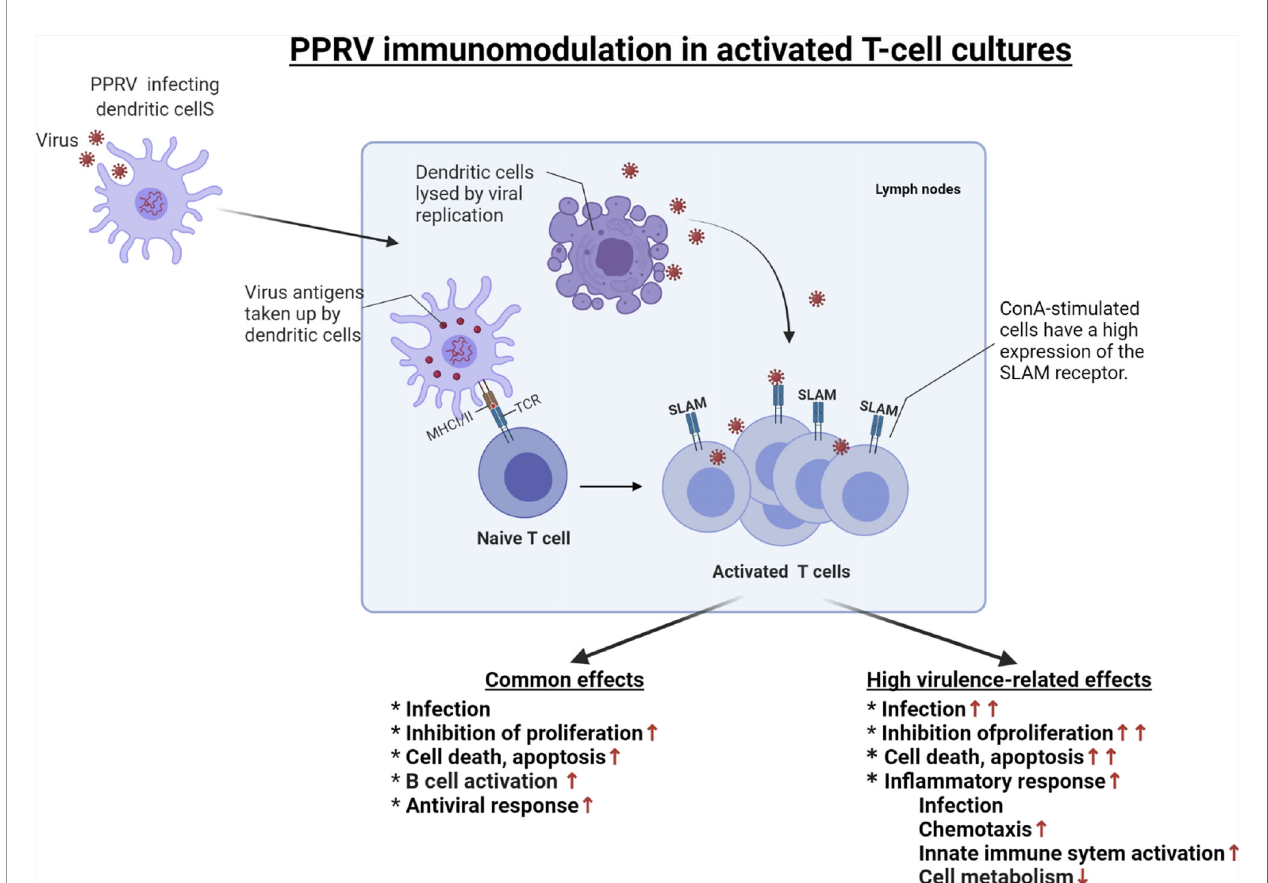
FIGURE 7 | Representation of the mechanisms involved in the infection of activated PBMCs by different virulence strains of PPRV. The fi rst steps of PPRV infectioninclude the transport of the virus by antigen-presenting cells (represented by dendritic cells) from the site of infection to the lymph nodes. Once in the lymph nodes, these cells trigger the activation and proliferation of T cells. This activation is associated with the expression of the SLAM receptor, as observed upon stimulation byConA. The virus may exit the DCs and then encounter the activated cells. The common effects of PPRV strains upon infection of activated T cells are the activation of an antiviral response, the inhibition of cell proliferation and the induction of cell death and apoptosis. In the case of a highly virulent strain, these activated cells are further infected and the in fl ammatory response is greater. Created with